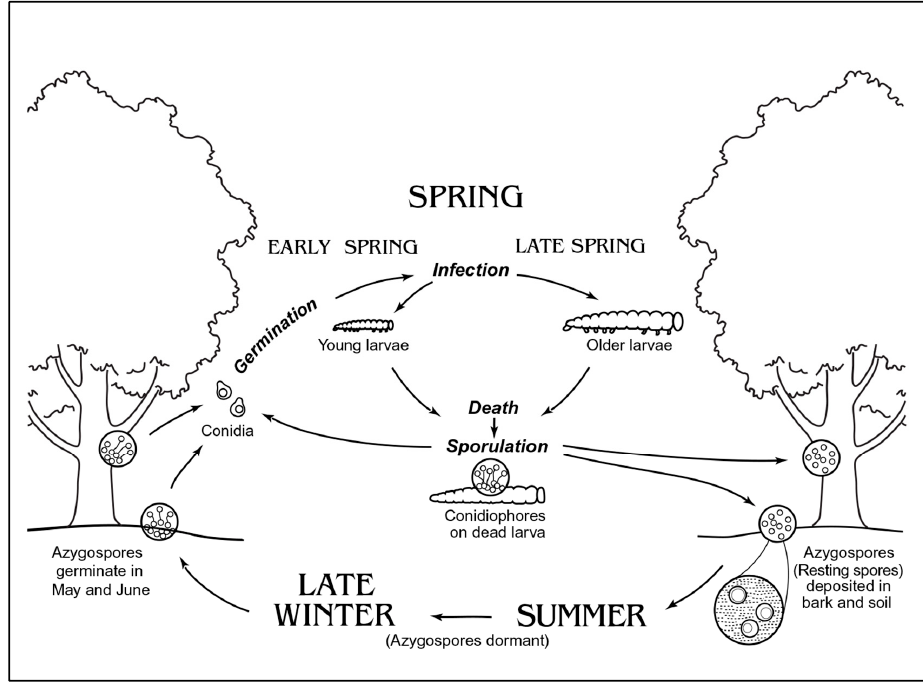
Figure 1. Life cycle of entomophthoralean fungus Entomophaga maimaiga infecting gypsy moth, Lymantria dispar . Generally, conidia are formed from infected younger larvae after death and resting spores are formed in the late spring/early summer within later instar larvae that often die on tree trunks. Resting spores within cadavers of later instars enter dormancy when drying. Cadavers containing resting spores eventually decompose on the soil surface and most resting spores persist in the surface layers of the soil during summer and winter, when the non-susceptible gypsy moth adults and eggs are present. In spring, when gypsy moth eggs begin to hatch, resting spores begin germinating to cause primary infections, leading to cycles of secondary infections that eventually result in production of resting spores that are dormant. Resting spores germinate over several months and not all resting spores in the soil germinate every year, so a reservoir of resting spores persists in the soil. (Graphic by Frances Fawcett).